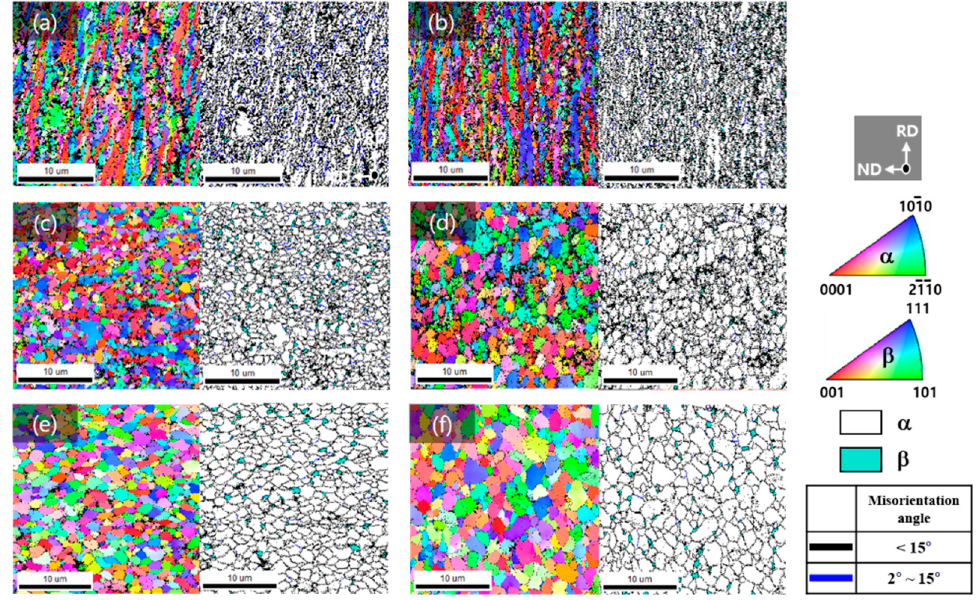
Figure 8. EBSD inverse pole figure maps and phase maps for ( a , c , e ) STEP-0 and ( b , d , f ) STEP-6. The micrographs were obtained after a strain of ( a , b ) 0%, ( c , d ) 100%, and ( e , f ) 300%.